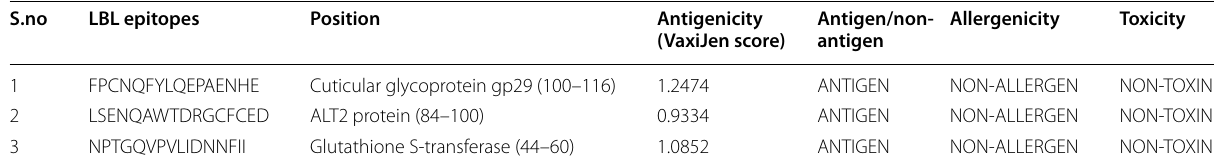
Table 5 B cell epitopes selected by FBCPred and ABCPred server